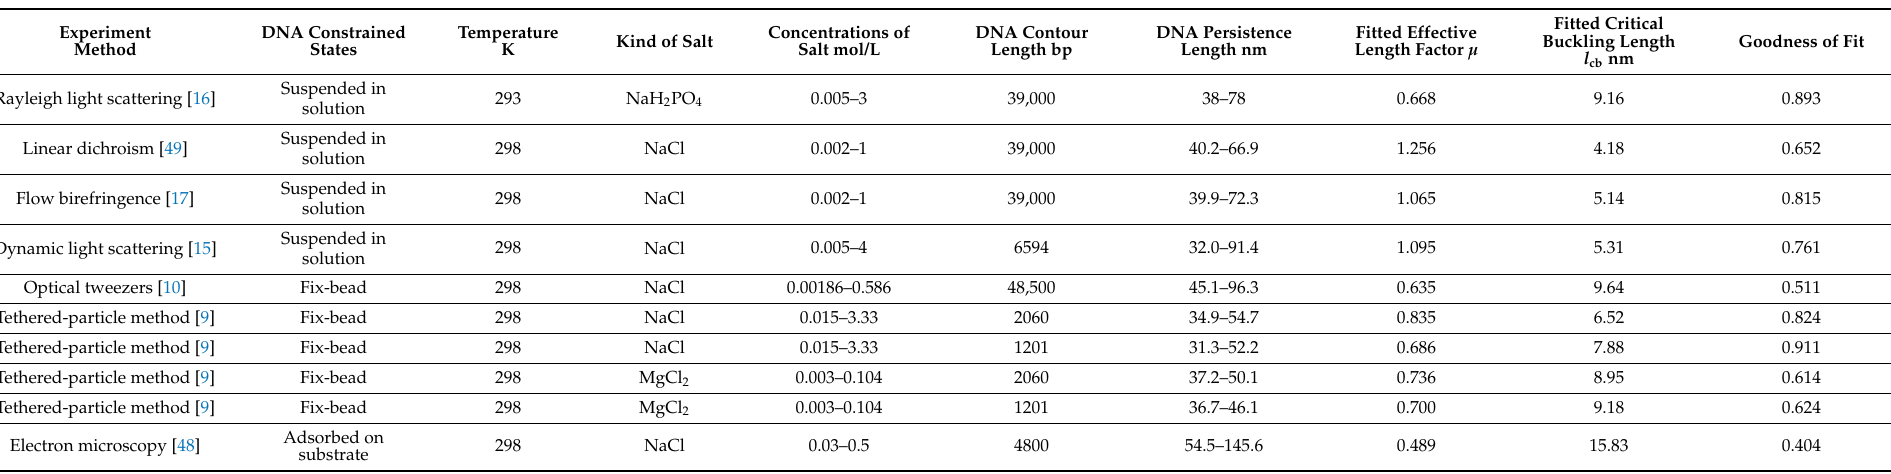
Table 1. Summary of experiments measuring DNA persistence length and corresponding fitted